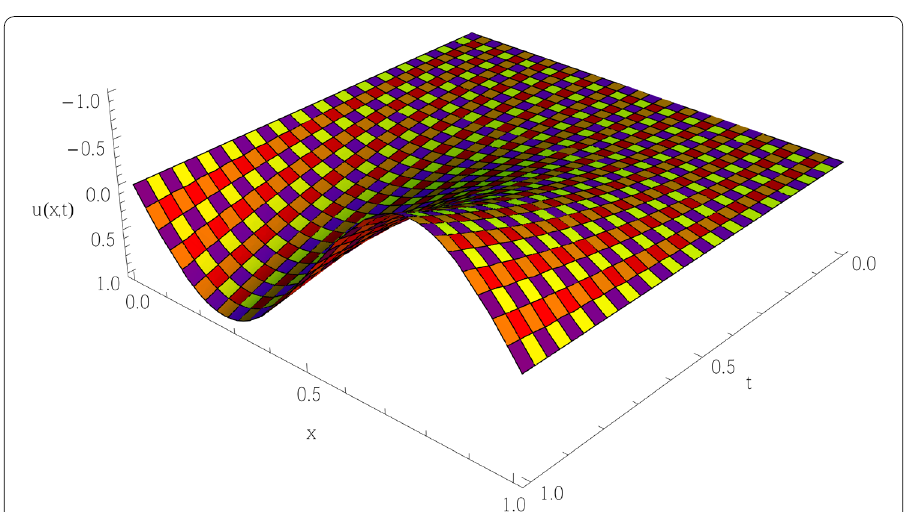
Figure 3 3D plot for N = 50, γ = 0.3, T = 1 of